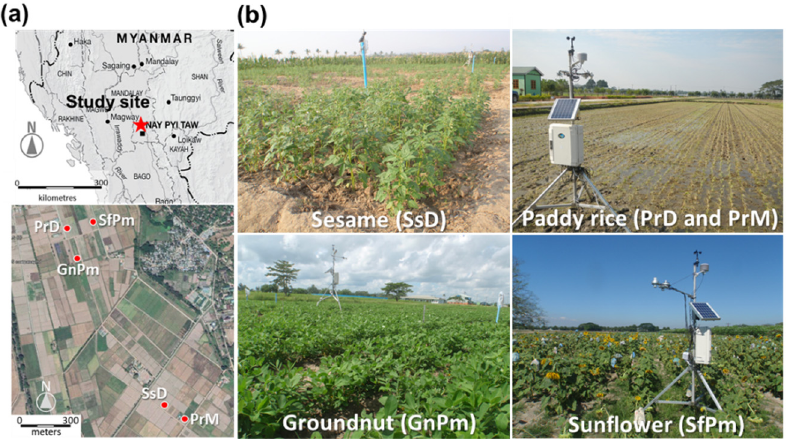
Figure 1. ( a ) Study site location and ( b ) experimental fields where evapotranspiration was observed. Table 1. Conditions of observation of crops, seasons, cultivation schedules, and soil, and the calibration/validation periods for model parameters using Bayesian approaches.